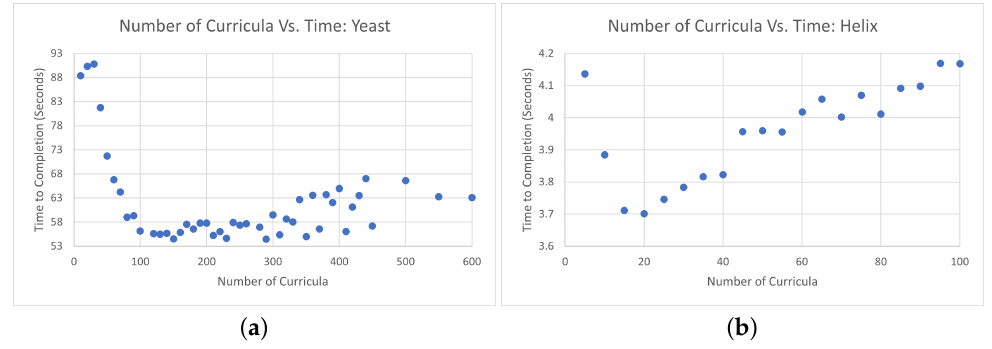
Figure 3. ( a ) Average run time of CBCR for various numbers of curricula evaluated on the yeast data over 30 trials. ( b ) Average run time of CBCR for various numbers of curricula evaluated on the helical data over 30